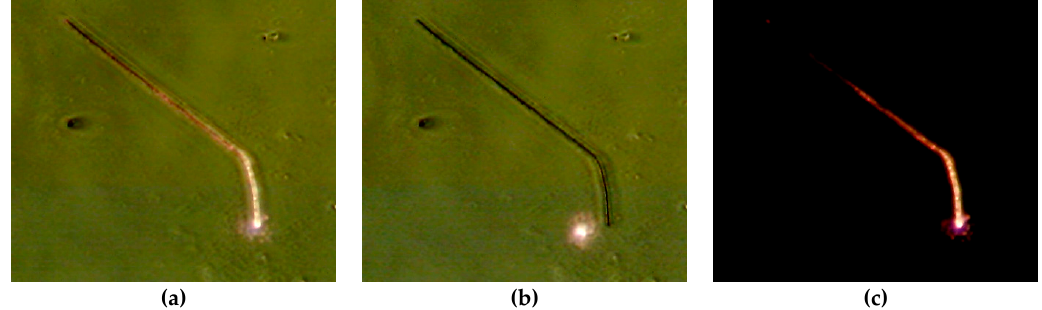
Figure 8. Images of the structure composed of a silver nanowire covered with a layer of up-converting nanocrystals. By controlling the position of the laser spot (980 nm) it is possible to demonstrate energy propagation in a metallic nanowire: ( a ) laser placed on the nanowire, ( b ) laser placed off the nanowire, ( c ) luminescence image measured in configuration ( a ).